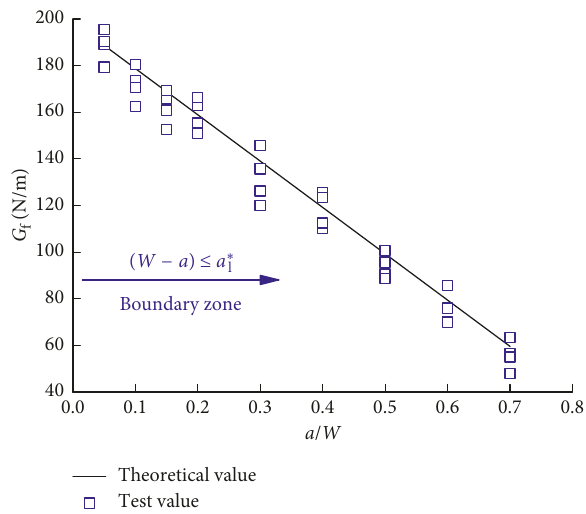
Figure 6: Theoretical values and test values of the fracture energy with different a / W ( W � 100mm). Table 4: Fracture energy G